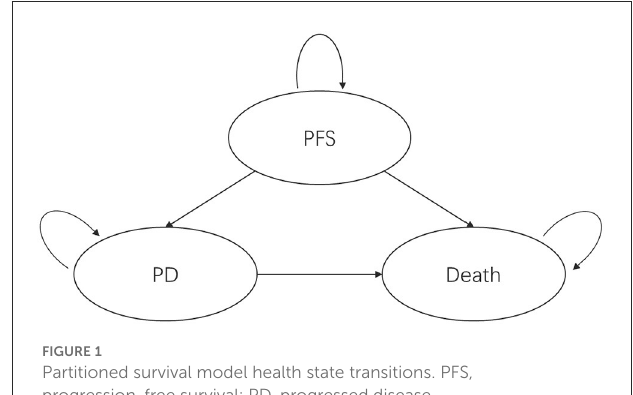
FIGURE1 Partitioned survival model health state transitions. PFS, progression-free survival; PD, progressed